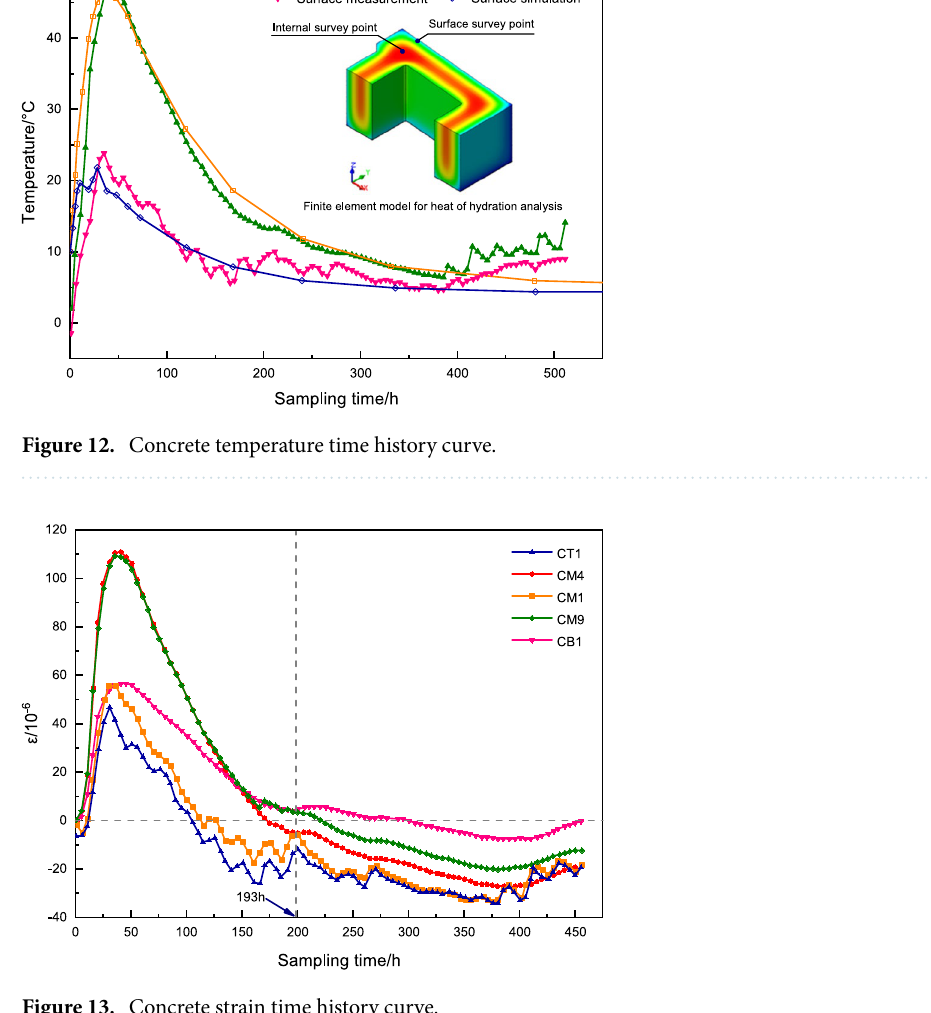
Figure 13. Concrete strain time history